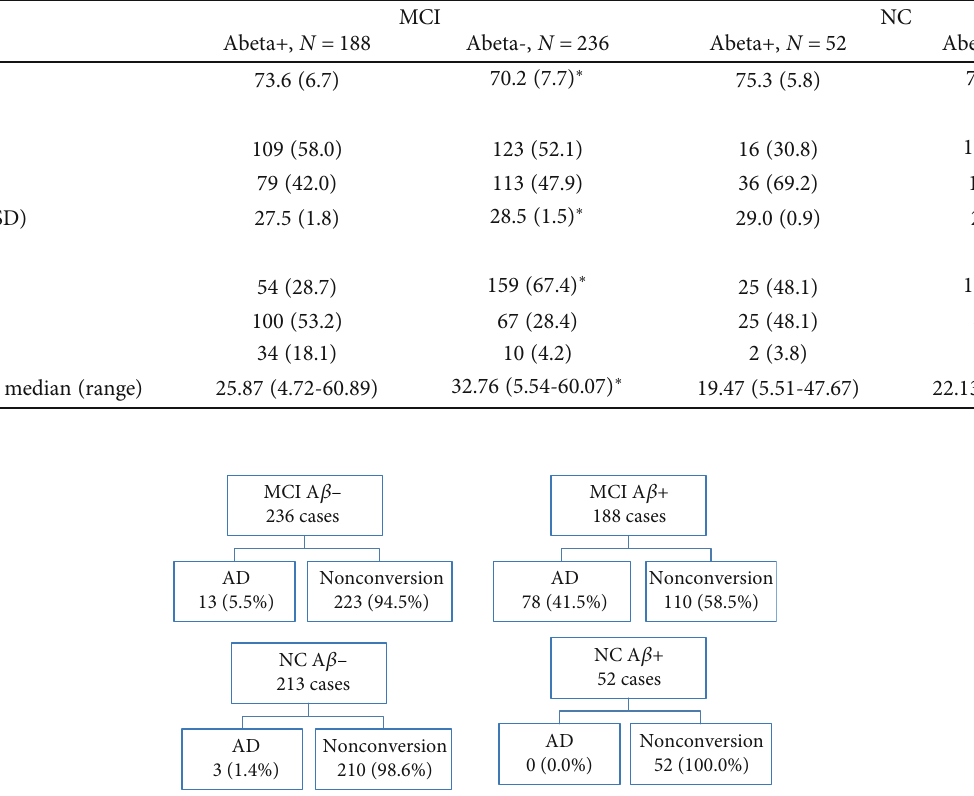
Figure 1: Outcomes of MCI and NC subjects based on PET brain Abeta. AD: Alzheimer ’ s disease; NC: normal cognition; MCI: mild cognitive impairment; A β - and A β +: brain PET imaging Abeta negative and Abeta positive, respectively. Table 2: The risk factors for conversion to AD by Cox